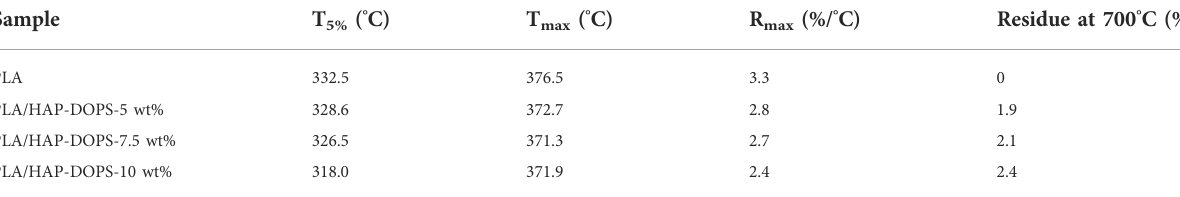
TABLE 1 TG and DTG data of PLA and PLA composites.